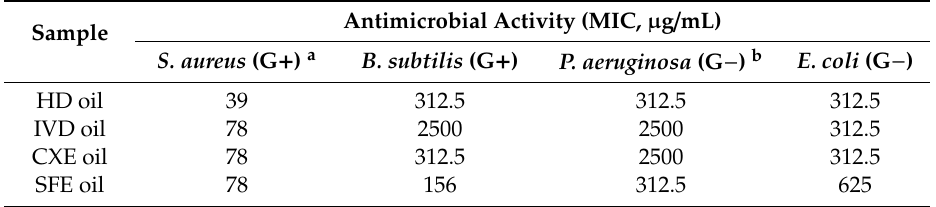
Table 3. Minimal inhibitory concentration of essential oil extracted from Vetiveria zizanioides